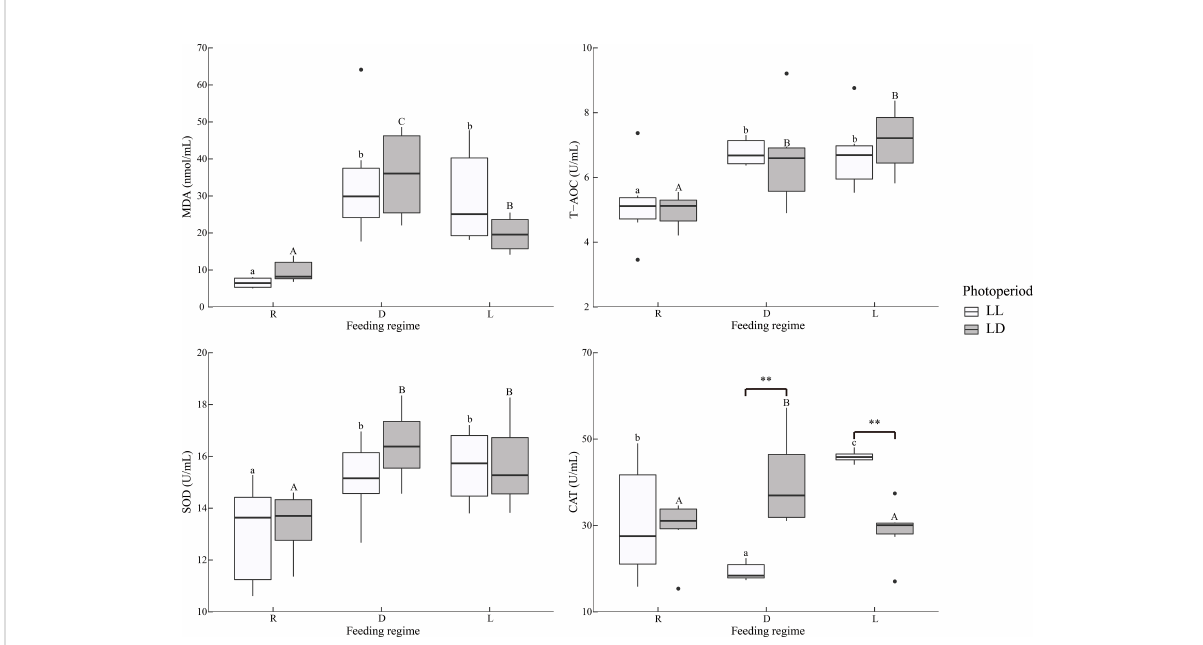
FIGURE 6 Serum antioxidant indicators of juvenile Oncorhynchus mykiss under different experimental treatments (n=6). MDA, Malondialdehyde; T-AOC, Total antioxidant capacity; SOD, Superoxide dismutase; CAT, Catalase; R, random feeding; D, mid-dark stage feeding; L, mid-light stage feeding; LL: 24L: 0D, LD: 12L: 12D. Different lowercase letters and capital letters indicate signi fi cant difference among different feeding regimes at the LL (24L: 0D) and LD (12L: 12D, lights-on at 6:00), respectively ( P < 0.05). Asterisks denote signi fi cant differences between photoperiods at the same feeding regime (** P < 0.01). Points outside the box plot are